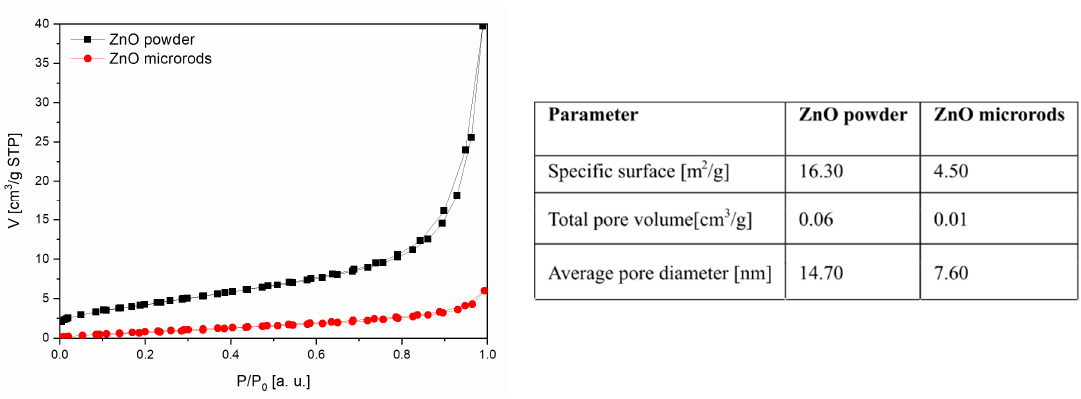
Figure 5. Zinc oxide XPS spectra in the form of: ( a ) powder; ( b ) microrods.